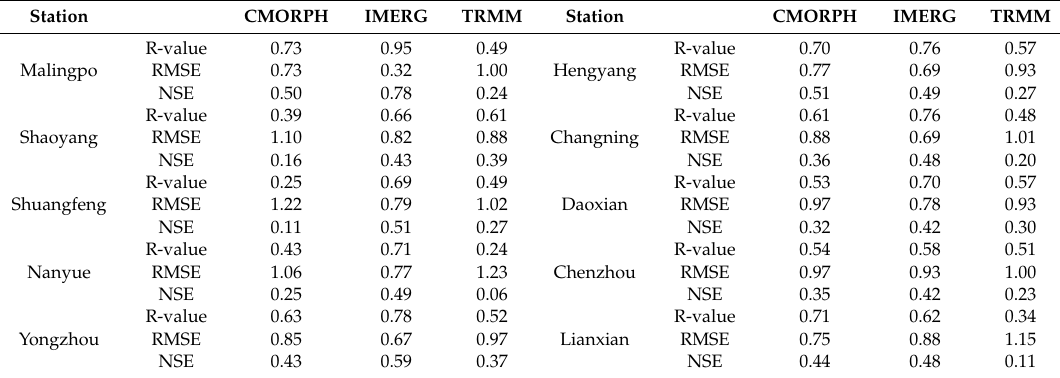
Table 2. SPI-1 comparison between satellites and in situ in each meteorological station.